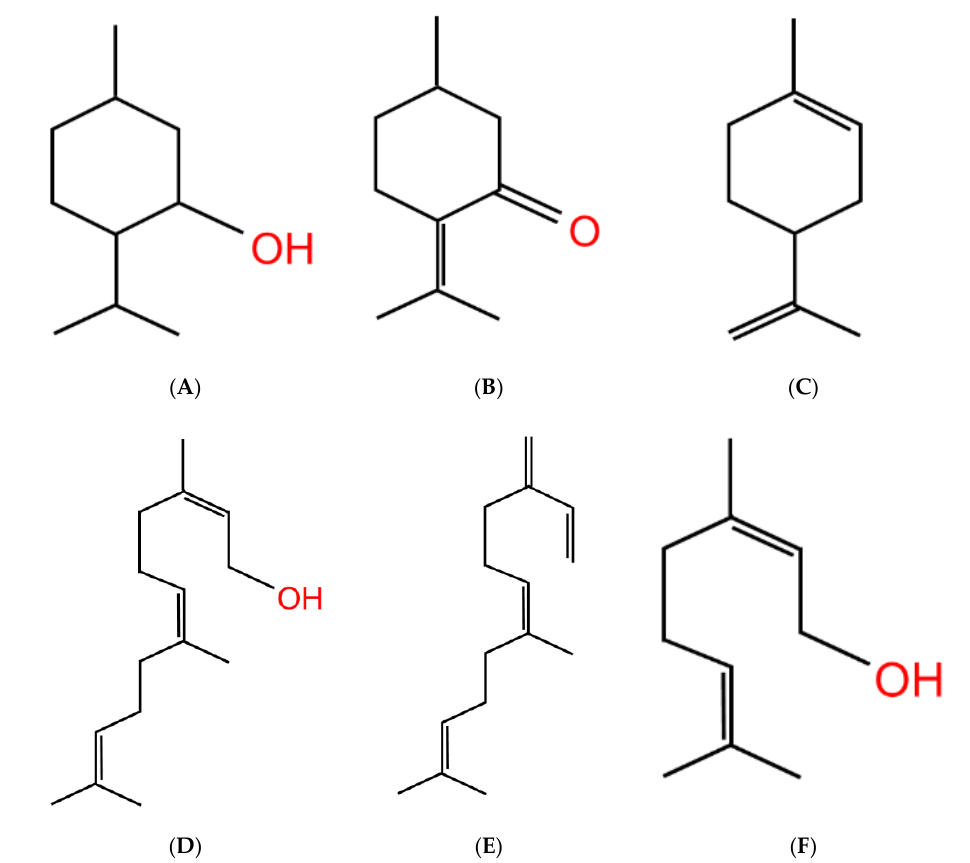
Figure 5. Flavorant chemical profiles. Similarity in chemical structure formation of ( A ) menthol, ( B ) pulegone (peppermint), ( C ) limonene (citrus), ( D ) farnesol, ( E ) farnesene, and ( F ) geraniol (fruity), despite the wide array of flavor profiles.